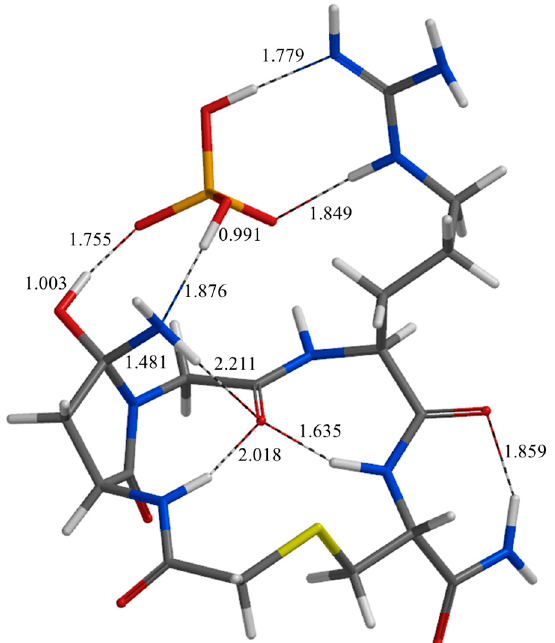
Figure 11. The geometry of IC4 (intermediate complex 4) lying between TS4 (Figure 10) and TS5 (Figure 12). Selected interatomic distances are shown in Å. Grey: carbon; white: hydrogen; blue: nitrogen; red: oxygen; orange: phosphorus; yellow: sulfur.